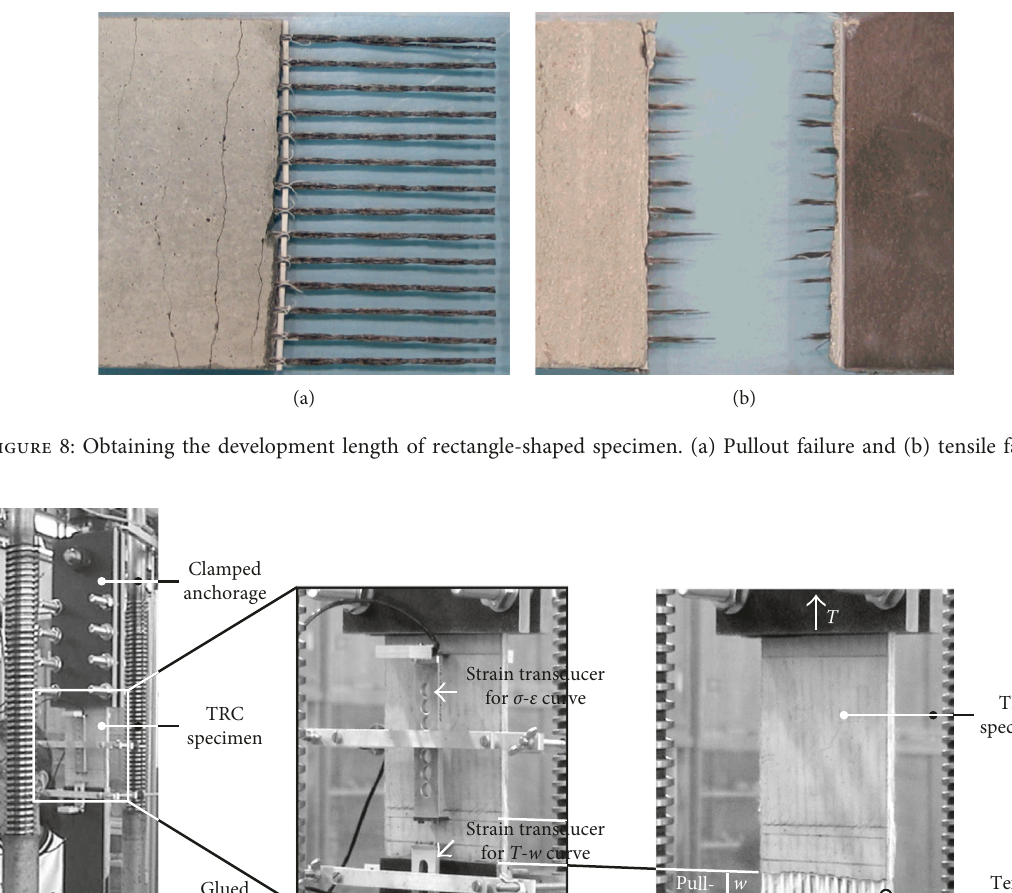
Strain transducer for σ - ε curve